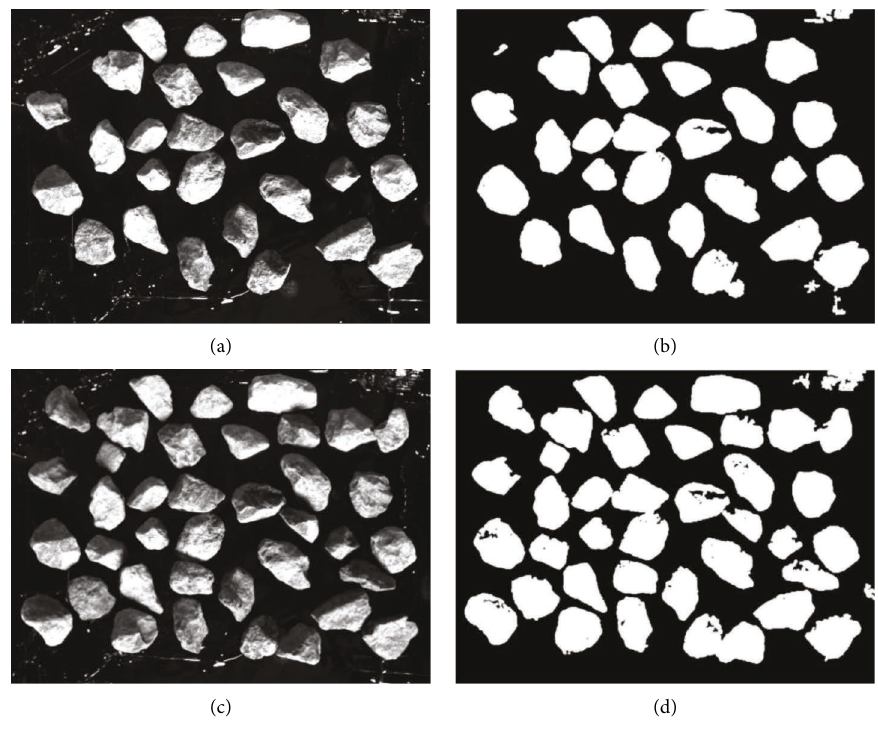
Figure 12: 16-19mm original image and inspection image.